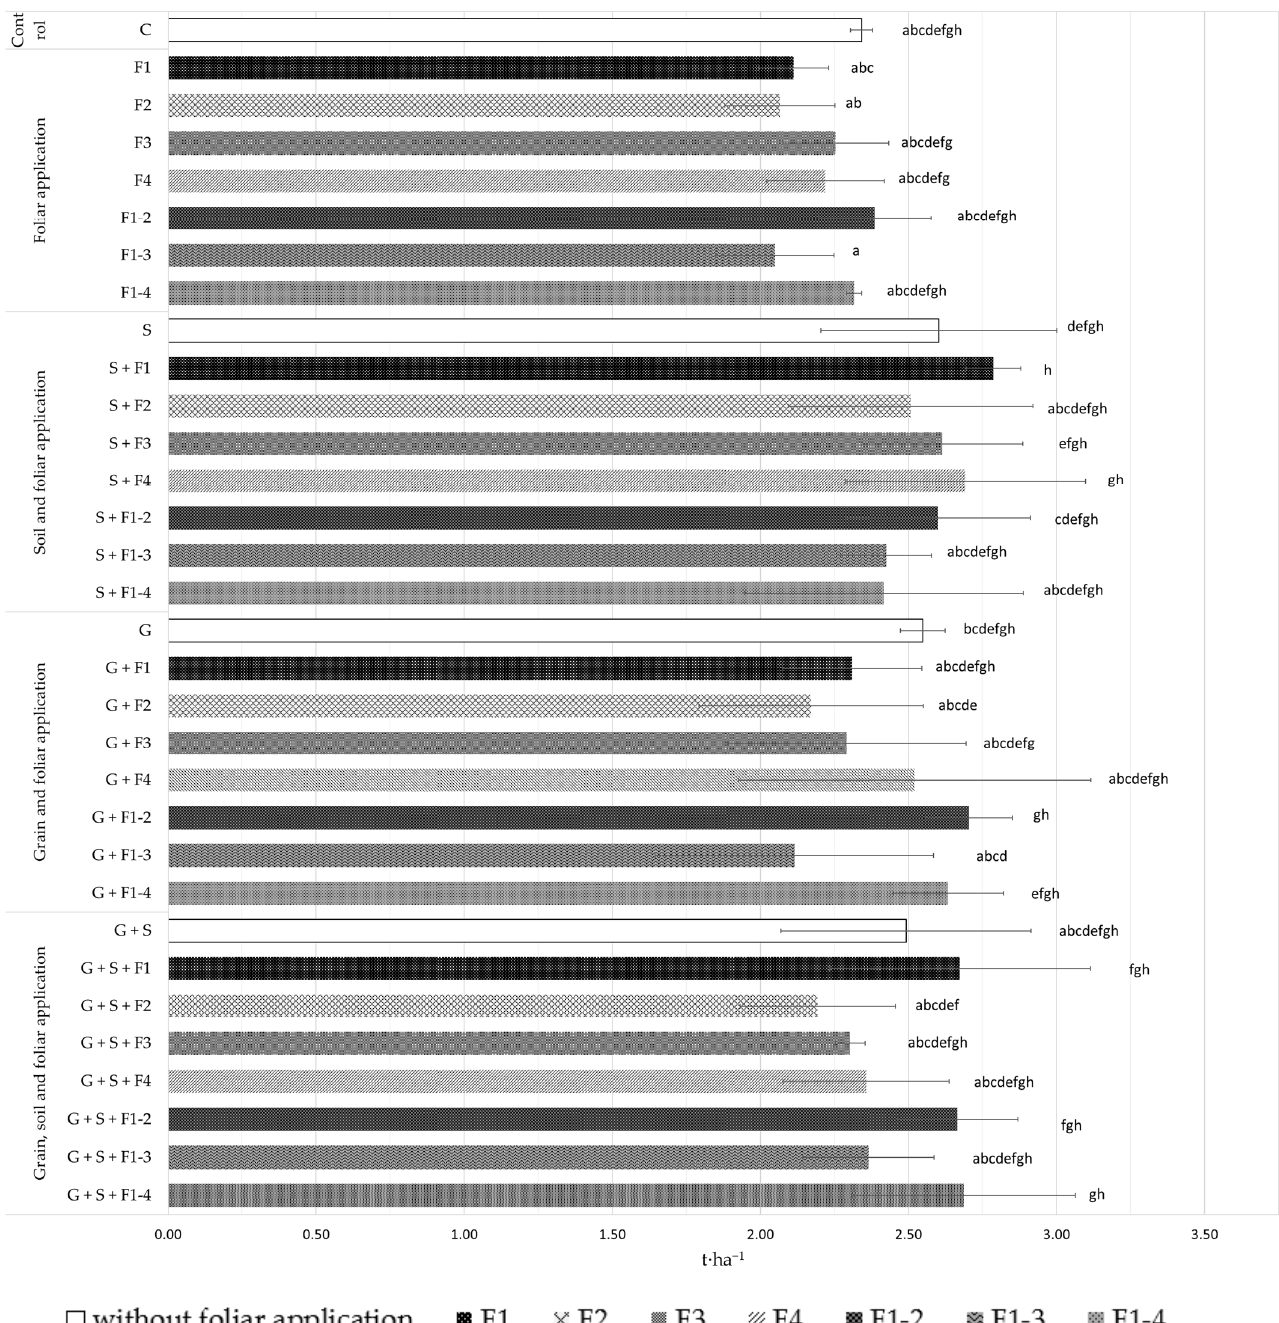
Figure 2. Average yield depending on fertilization. Results show means and standard errors ( n = 3). a, b, c—means followed by the same letter are not significantly different from one another based on Tukey’s test at p ≤